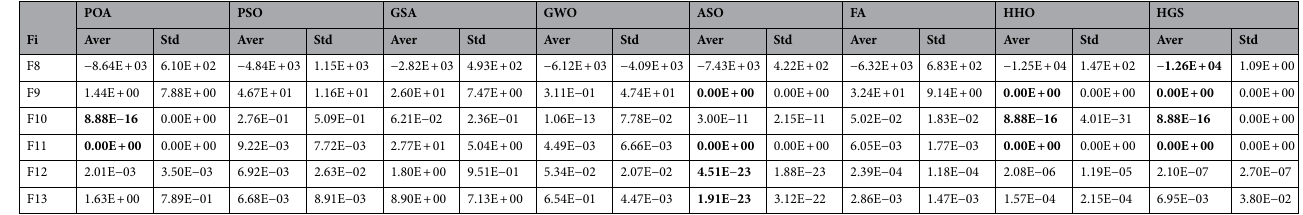
Table 3. Results of multimodal benchmark functions. Significant values are in